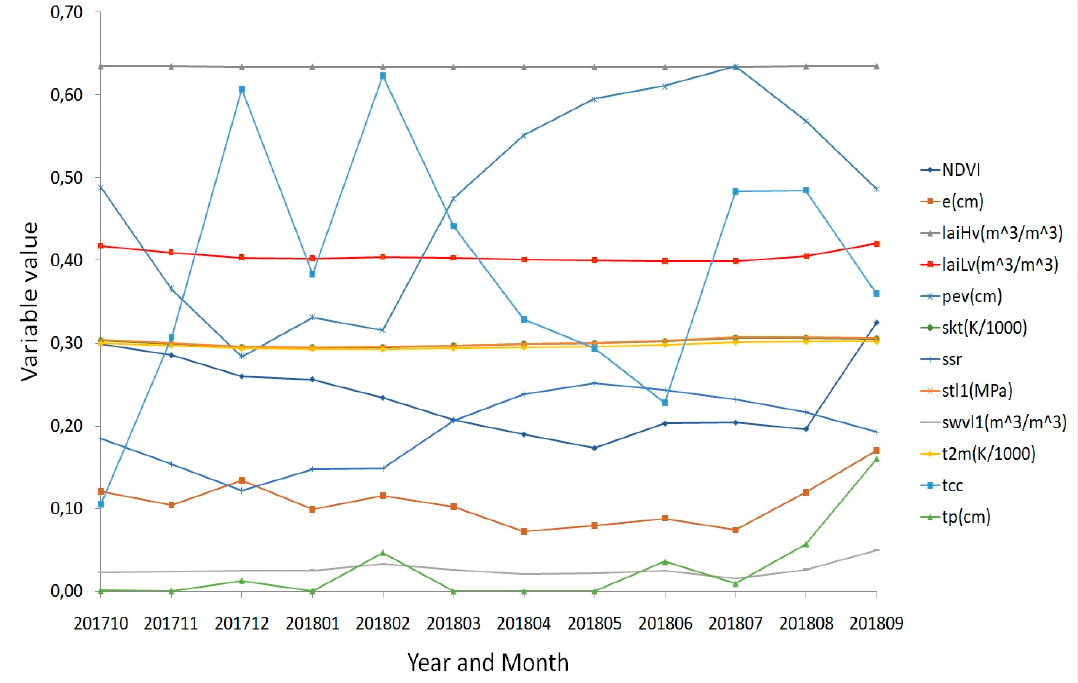
Figure 2. Variables evolution from October 2017 to September 2018 in the municipality of Comondú in the state of Baja California.